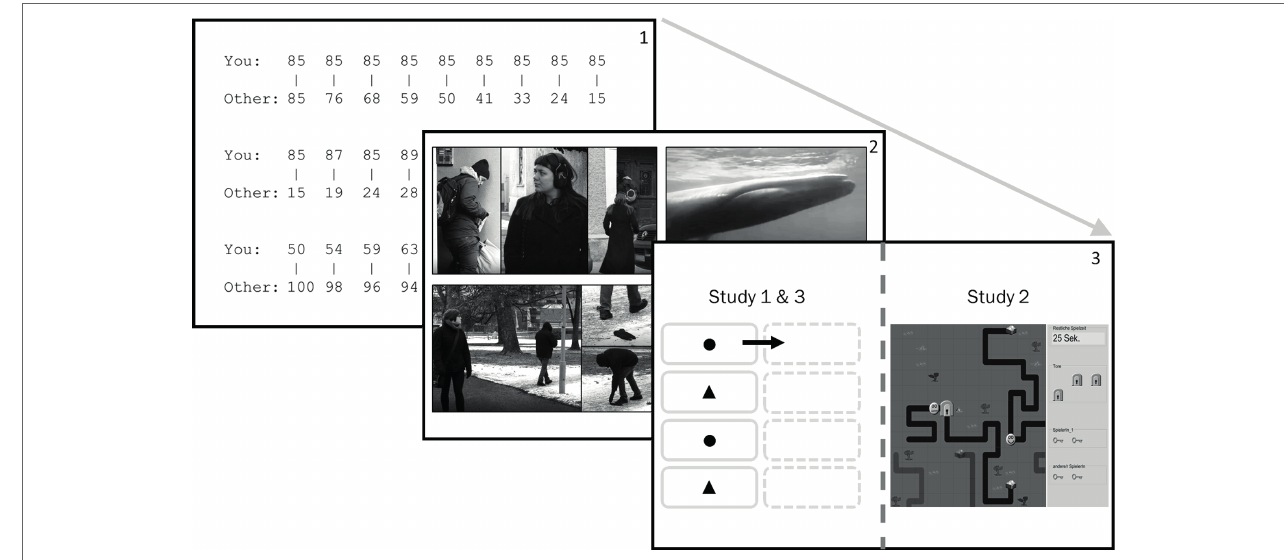
FIGURE 1 | General set-up of Study 1–3. (1) Data on SVO was collected prior to the manipulation (Murphy et al., 2011). (2) Goal manipulation was carried out through texts in Study 1 and video clips in Study 2 and 3. (3) DVs were measured with a drag and drop task in Study 1 and 3, and with the ZPG in Study 2. Note that written informed consent was obtained from all depicted individuals for the publication of these